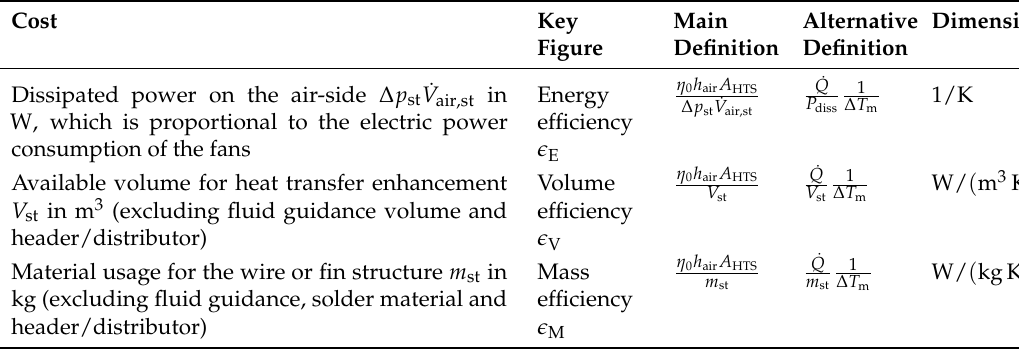
Table 2. Key figures for extended performance evaluation; defined as benefit η 0 h air A HTS per cost. The main definition and the alternative definition are equal, but differ in the input